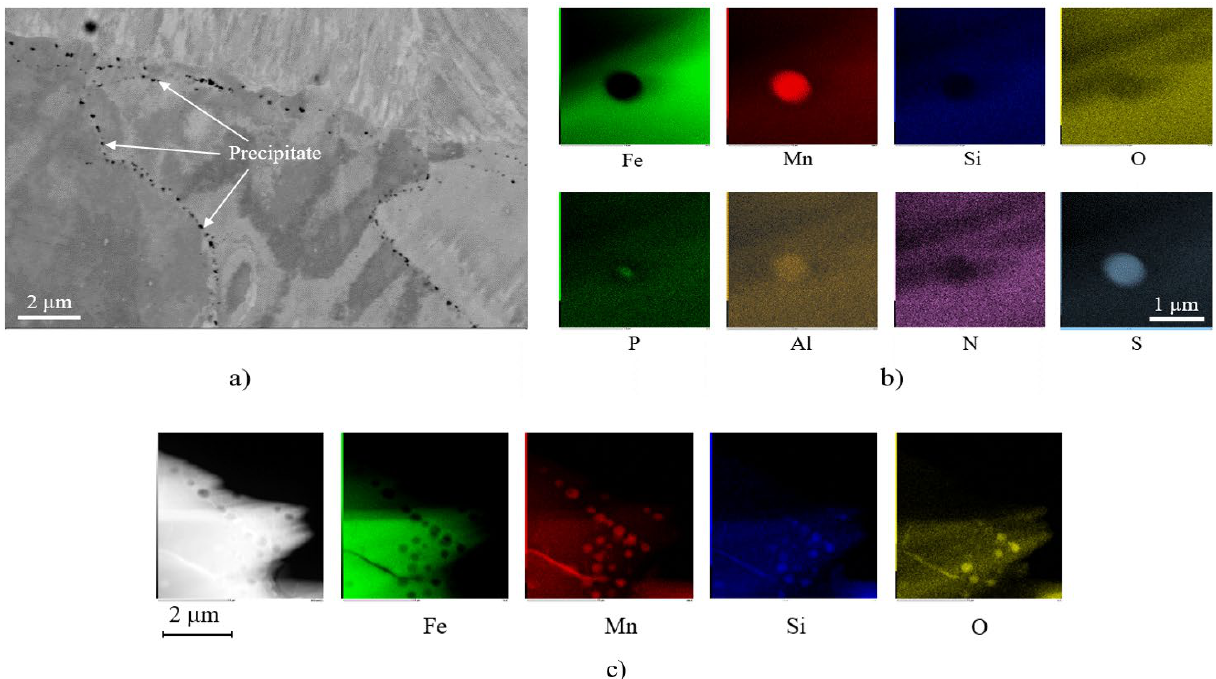
Figure 7. ( a ) SEM image showing precipitates in direct strip cast (DSC) specimen annealed at 630 °C for 10,000 s; ( b , c ) TEM chemical mapping of a thin slab cast (TSC) specimen annealed at 630 °C for 10,000 s. Particle shown in ( b ) is from the population of larger Mn and S enriched particles. Particle cluster shown in ( c ) is from the population of smaller particles that cluster at the grain boundaries. Note that the SEM image shown in ( a ) is from a different specimen to those shown in ( b , c ).